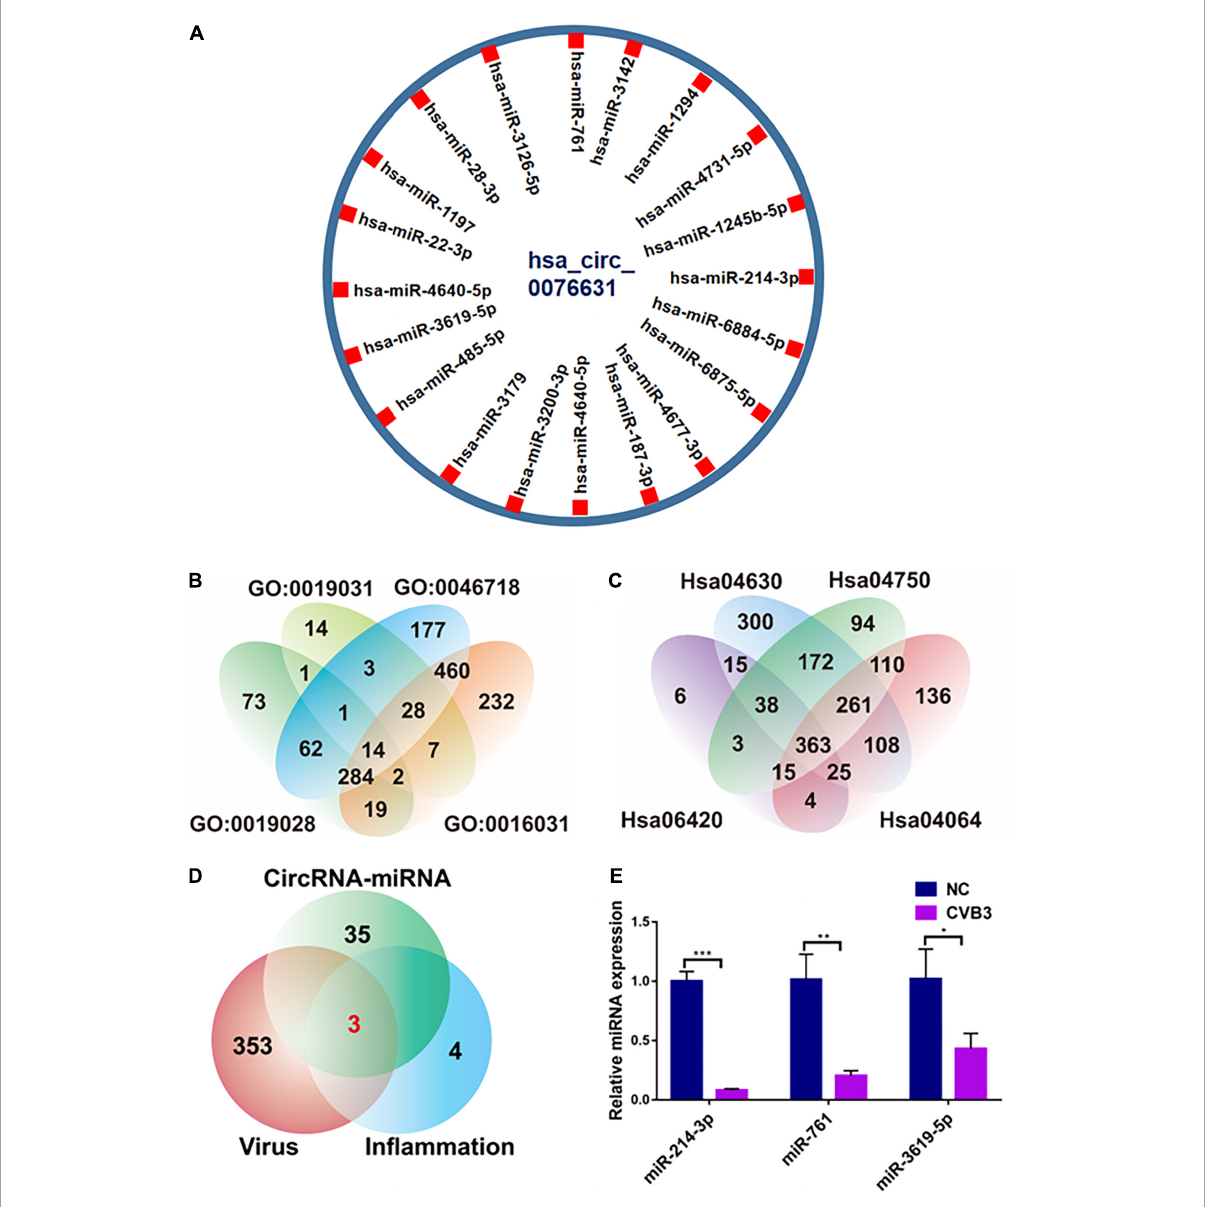
FIGURE3 Prediction of miRNAs that may bind to targeting circ_0076631. (A) Screening the potential miRNAs that may bind to circ_0076631. (B,C) Screening of the miRNAs related to the inflammatory pathway and viral infection. (D) Comprehensive analysis of the three aforementioned screening results. (E) HeLa cells were infected with CVB3 (MOI = 10) for 6 h, and the abundance of miRNAs was measured by RT-qPCR. n = 3. * P < 0.05, ** P < 0.01, *** P <